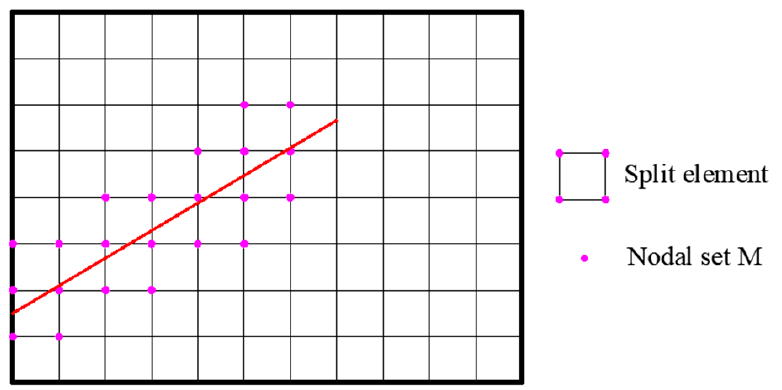
Figure 2. Nodal subsets and element types.